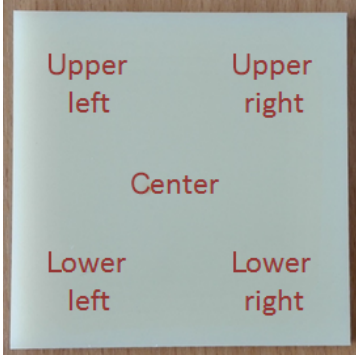
Figure 4. Measurement positions on PE-Xc